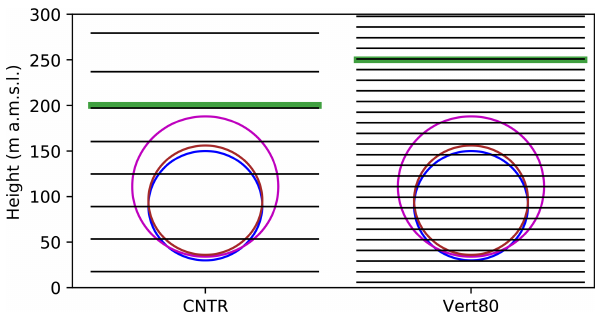
Figure 3. Distribution of the vertical levels with height and the lev- els intersecting with the rotor areas of the two wind turbine types used in the wind farms, as listed in Table 3 for the CNTR and Vert80 simulations. The rotor areas of the wind turbines SIEMENS-SWT- 6.0-154, SIEMENS SWT 3.6-120 and SENVION 6.2 are shown in magenta, blue and red, respectively. The green lines denote flight heights at 200 and 250ma.m.s.l., which is necessary due to the dif- ferent wind turbine heights. cause different wind turbine types are designed for different wind